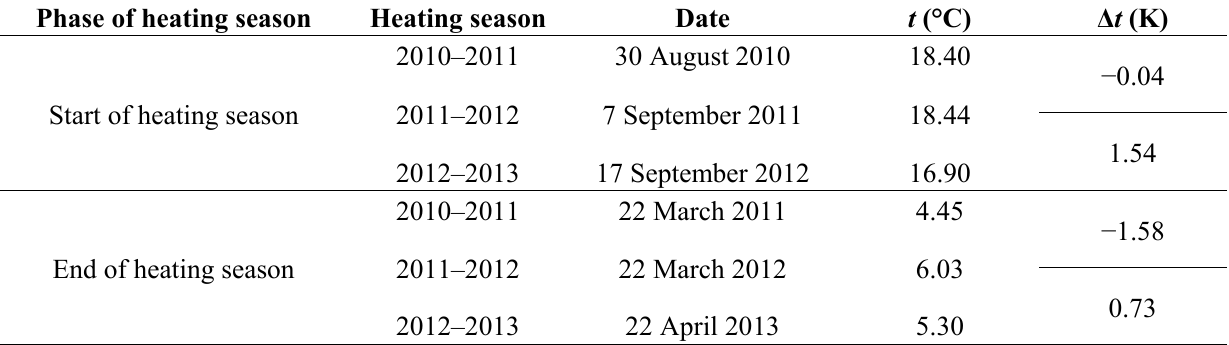
Table 3. Average daily temperatures of the soil at the start and end of the heating seasons. Phase of heating